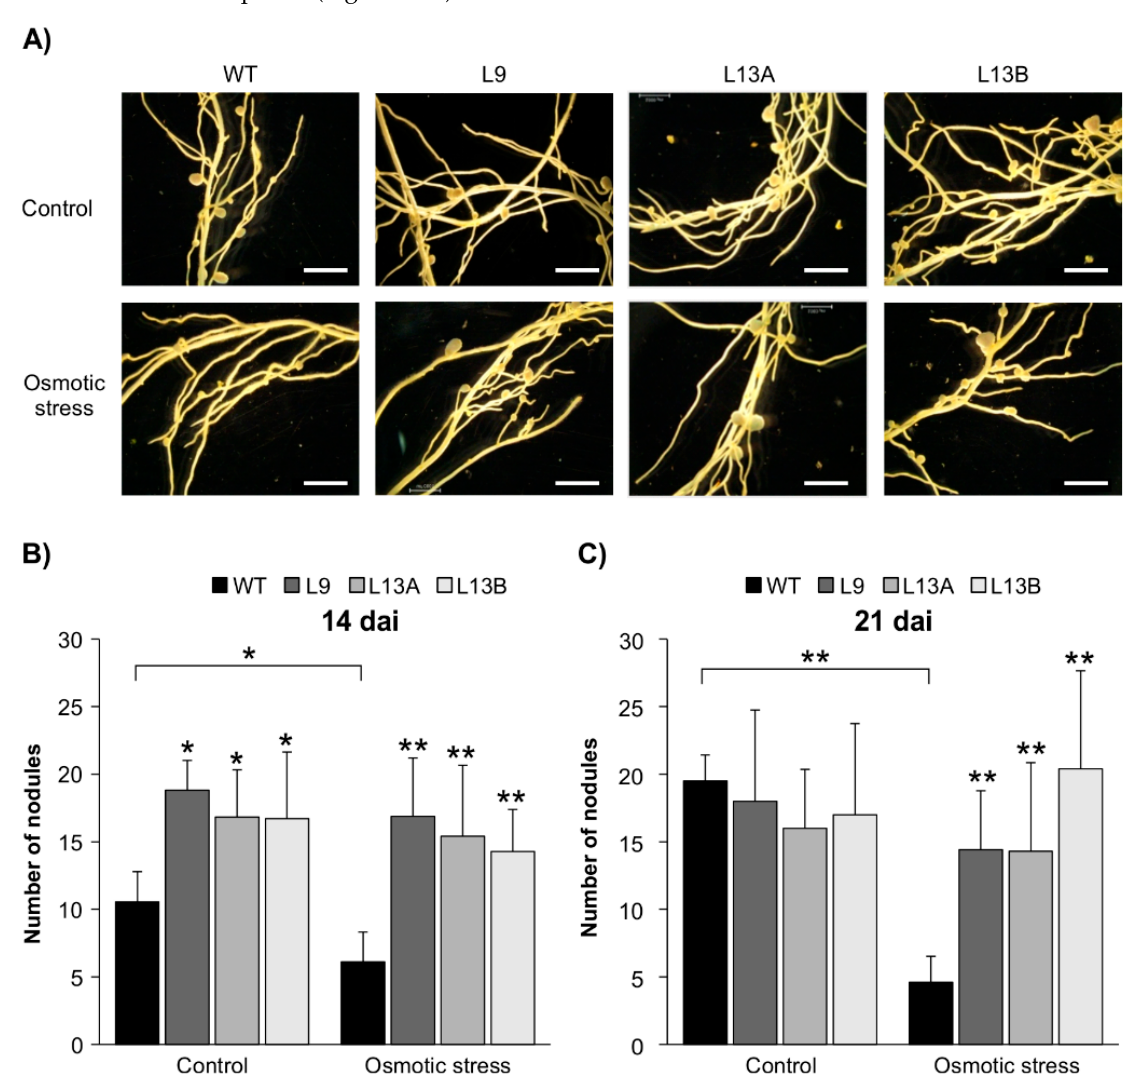
Figure 10. Effect of AGL6 silencing on nodulation under osmotic stress. ( A ) Nodule phenotypes of WT and AGL6 -RNAi plants that were exposed to osmotic stress (400 mM) (21 dai). Scale bars: 3 mm. ( B ) The number of nodules in WT and the AGL6 -RNAi alfalfa under control and osmotic stress conditions (n = 12–15) at 14 dai, and ( C ) 21 dai (n = 8–11 plants). * and ** indicate significant differences relative to WT using Student’s t -test p < 0.05, p < 0.01, respectively. Error bar indicates standard deviation.